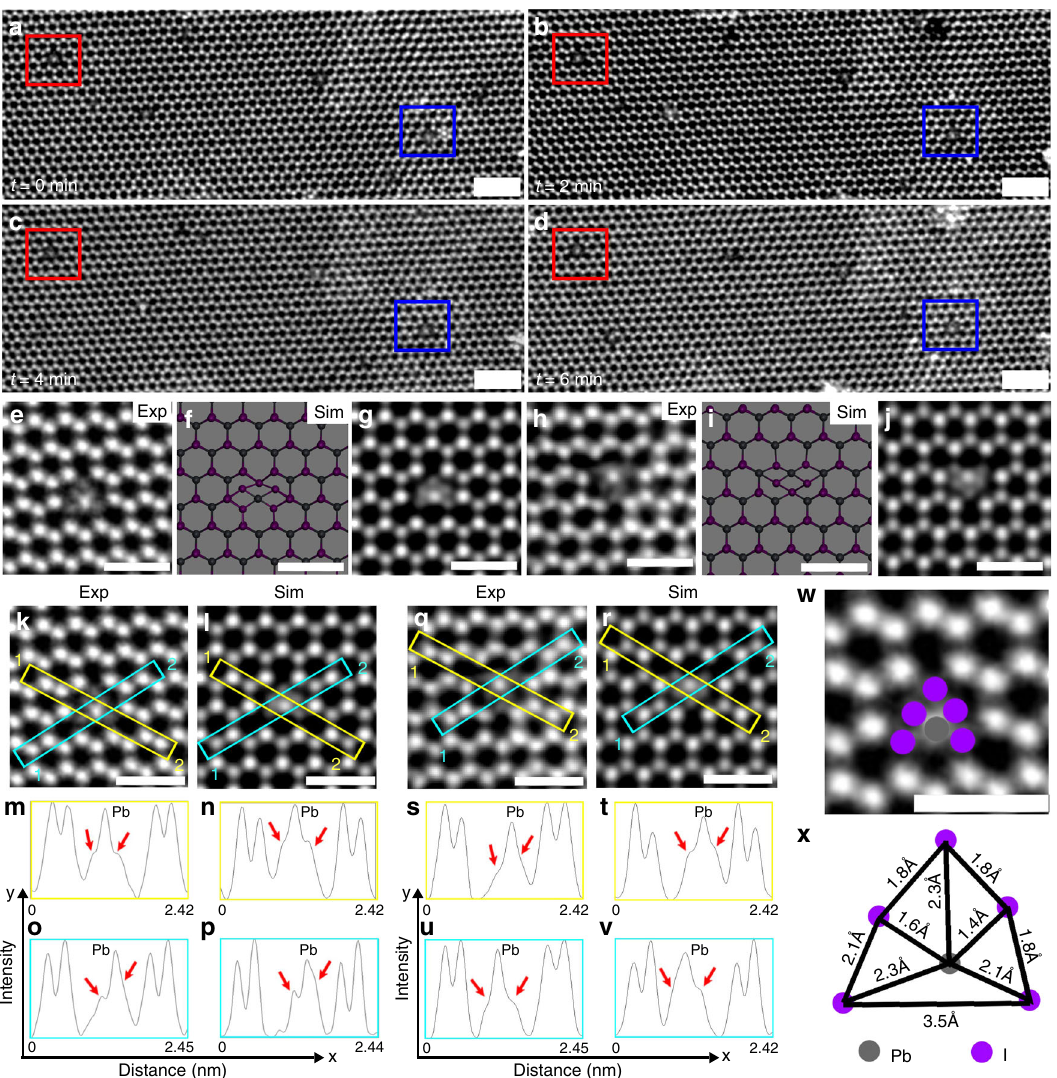
Fig. 6 Stable defect dynamics in PbI 2 . a – d Time-lapse ADF-STEM images taken after every 2 min. The red and blue boxes show the two different orientations of the substitutional defect, which is rather stable under the electron beam exposure. e ADF-STEM image of a defect with lead in the center and surrounded by fi ve other iodide atoms. f Atomic model that shows the atomic model of the corresponding experimental result. g Multislice image simulations based on the atomic model in f , schematically illustrating the lower intensity of the single iodide atoms surrounding the lead, which agrees with the experimental data in e . m , n Line pro fi le taken across the lead and iodide atoms across the yellow annotated regions in the experimental data k and multislice simulated image in l . The red arrow shows unresolved iodide peaks around the lead. o , p Line pro fi le taken across the lead and iodide atoms across the blue annotated region in k and l , respectively. The red arrow shows unresolved iodide peaks around the lead. j , h ADF-STEM image of the opposite orientated substitutional defect. i Atomic model that shows the atomic model of the corresponding experimental result. j Multislice image simulations based on the atomic model in i , schematically illustrating the lower intensity of the single iodide atoms surrounding the lead, which agrees with the experimental data in h . s , t Line pro fi le taken across the lead and iodide atoms across the yellow annotated regions in the experimental data q and multislice simulated image in r . The red arrow shows unresolved iodide peaks around the lead. u , v Line pro fi le taken across the lead and iodide atoms across the blue annotated region in q and r , respectively. The red arrow shows unresolved iodide peaks around the lead. w Annotated image of e . x Distance between the different atoms shown in the annotated region in w . Scale bars in a – d correspond to 2 nm, whereas in the rest of the images correspond to 1